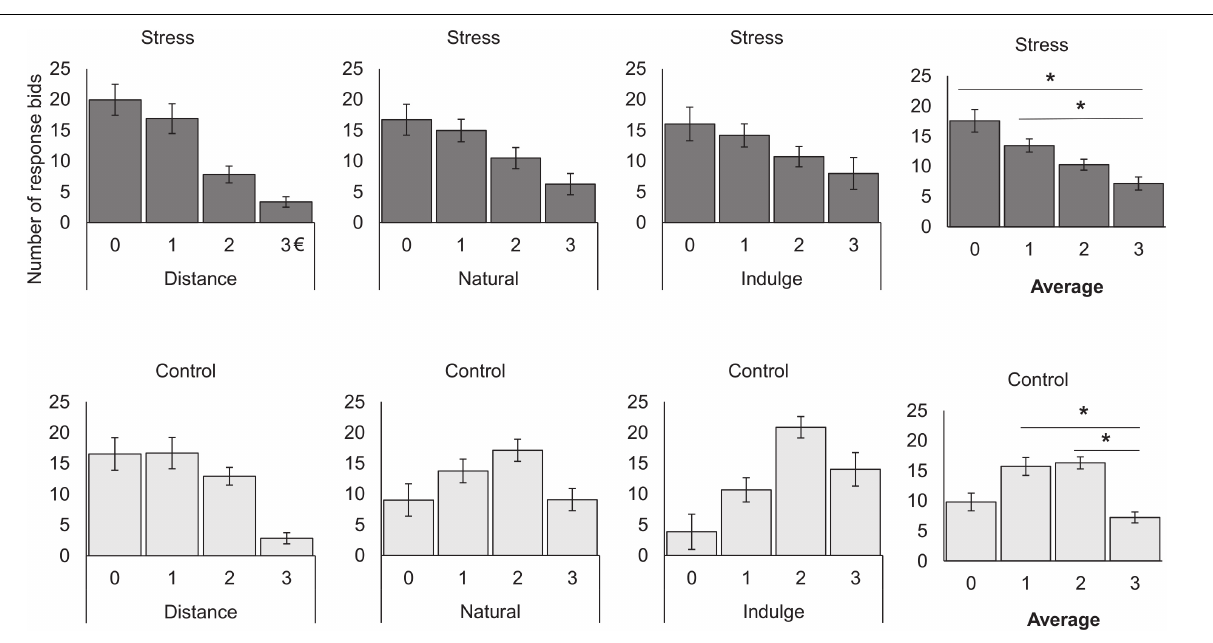
FIGURE 4 | Representation of the number of responses for the stress and control groups during bidding for each cognitive regulation trial and for the average of all trials. On average, the stress participants bided more often 0 [ t ( 14 ) = 3.93, p = 0.009, d = 1.78] and 1 € [ t ( 14 ) = 3.38, p = 0.027, d = 1.81] than 3 €, while control subjects bided more times 1 [ t ( 13 ) = 3.94, p = 0.010, d = 2.18] and 2 € [ t ( 13 ) = 5.91, p = 3.090 × 10 − 4 , d = 3.28] than 3 €. The black star represents statistically significant differences. The main bars represent the mean values and the error bars represent the standard